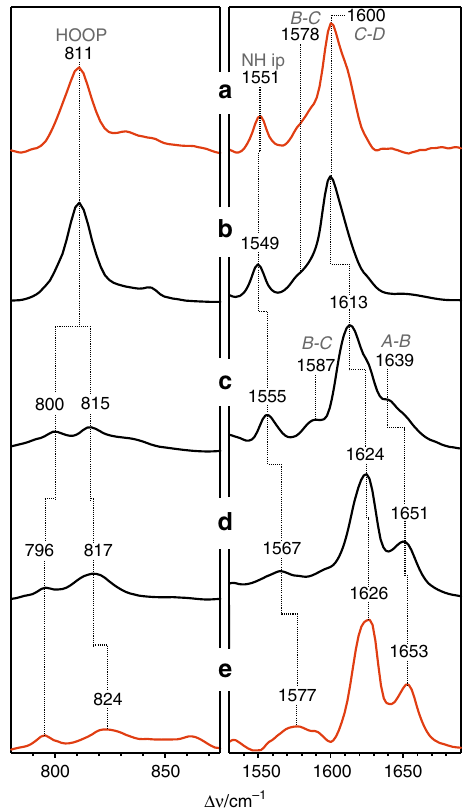
Fig. 4 Experimental resonance Raman spectra of Agp2-PAiRFP2, measured from frozen solution and single crystals at 90 K. a Pfr, crystal; b Pfr, frozen solution; c Lumi-F, frozen solution obtained by irradiation at ca. 130 K; d Meta-F obtained by irradiation at ca. 240 K, frozen solution; e Meta-F obtained by irradiation at ca. 240 K, crystal. The RR spectra of Pfr measured from the crystal (trace a ) and from frozen solution (trace b ) are nearly identical. Upon irradiation of Pfr at 130 K, Lumi-F is obtained (trace c ), whereas the subsequent intermediate Meta-F (trace d , frozen solution) was trapped upon irradiation at ca. 240 K. The spectrum of the irradiated crystals displays far-reaching similarities with that of Agp2-PAiRFP2 in frozen solution and irradiated under the same conditions and thus allows the unambiguous assignment of the Meta-F state (trace e ). Note that, as for the solution spectra, there are essentially no spectral differences if the crystals are irradiated at 240 or 273 K. Only minor differences exist between the RR spectra of the Meta-F states in frozen solution and in the crystalline form (see also Supplementary Fig.